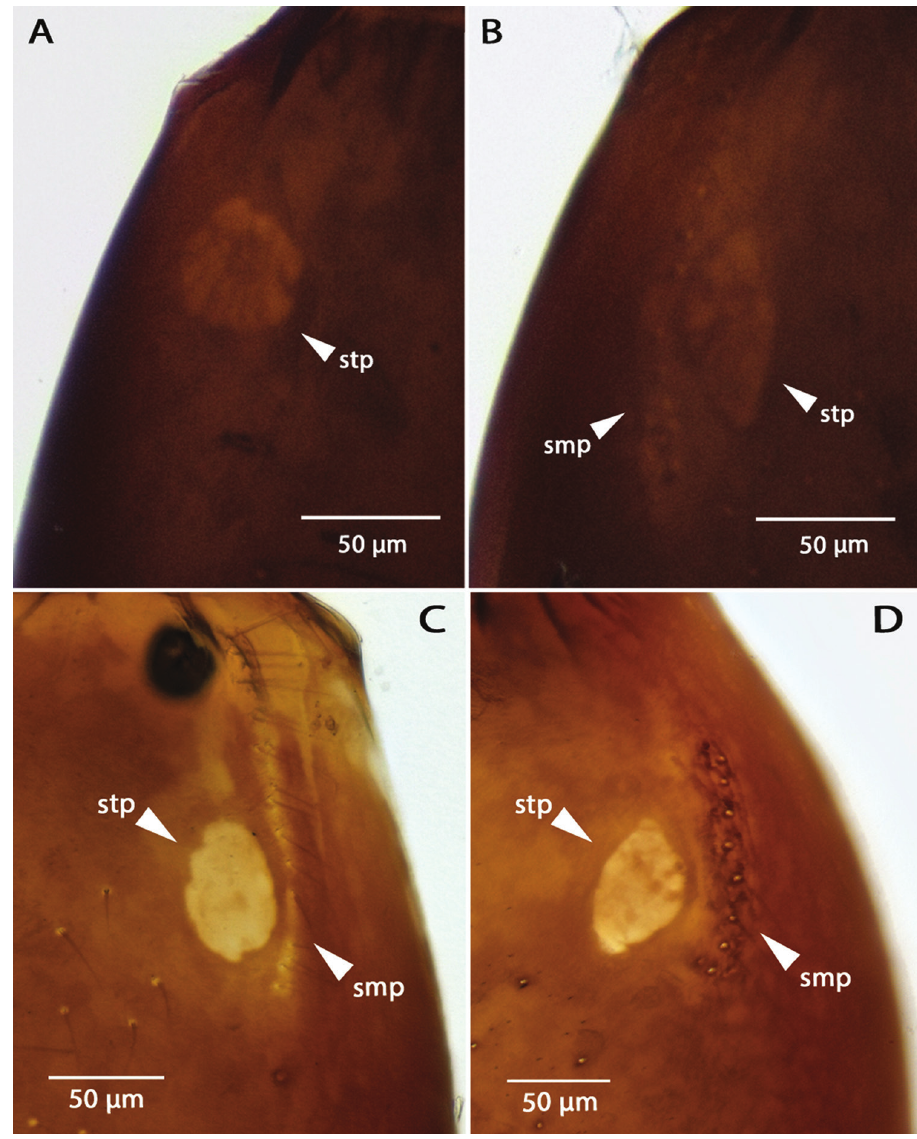
Figure 1. Brightfield images of syntergal and synsternal translucent patches and synsternal setiferous patches in different species of Conostigmus (Hymenoptera: Megaspilidae), viewed externally. A Dorsal surface (syntergite) within a C. bipunctatus Kieffer, 1907 (Hymenoptera: Megaspilidae) specimen (identi- fier: IM 1751) B Ventral surface (synsternite) within the same C. bipunctatus specimen C Ventral surface of Conostigmus sp. C7A (identifier: CLEV 22741) D Ventral surface of Conostigmus sp. C7B (identifier: PSUC_FEM 83781) Abbreviations: smp = synsternal setiferous patch; stp = syntergal/synsternal translu- cent patch. The species notations given are not issued for purposes of zoological nomenclature, and are not published within the meaning of the International Code of Zoological